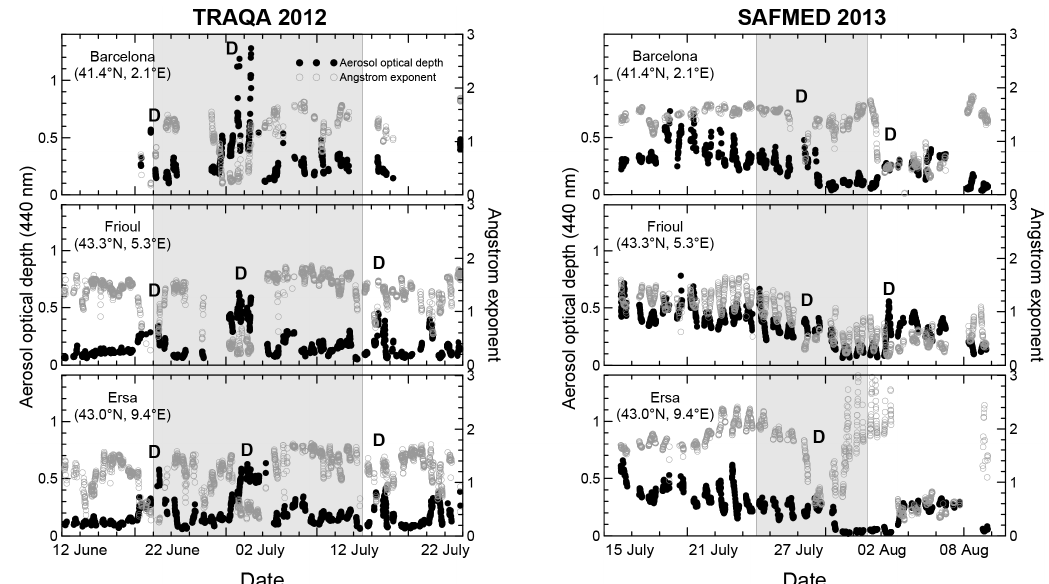
Figure 2. Aerosol optical depth at 440nm ( τ) and Ångström exponent ( α) measured at the Barcelona, Frioul, and Ersa AERONET stations during the TRAQA 2012 (left panels) and the SAFMED 2013 (right panels) campaigns. The time period for the different plots is ± 10 days around the beginning/end of the two campaigns (data for the Barcelona station are not available over the entire 2012 period). The label D indicates the days affected by Saharan